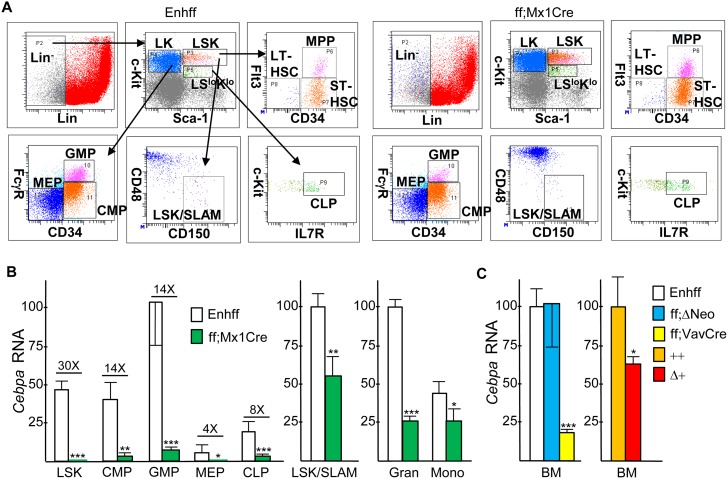
Effect of in vivo Enhancer Deletion on Cebpa Hematopoietic Expression.A) Representative FACS analyses of marrow stem/progenitor subsets. GMP, CMP, and MEP were analyzed within the Lin-Sca-1-c-kit+ (LK) subset, CLP were analyzed within the Lin-Sca-1loc-kitlo (LSloKlo) subset, and MPP, ST-HSC, LT-HSC, or LSK/SLAM cells were enumerated within the Lin-Sca-1+c-kit+ (LSK) subset. B) Total cellular RNAs from the LSK, CMP, GMP, MEP, CLP, LSK/SLAM, granulocyte, or monocyte marrow subsets isolated from Enh(f/f) or Enh(f/f);Mx1-Cre mice that had been subjected to pIpC injections and allowed to recover for 4 wks were analyzed for relative Cebpa mRNA expression, normalized to mS16 mRNA expression (mean and SD from three determinations). C) Relative Cebpa mRNA expression was analyzed similarly from marrow mononuclear cells isolated from Enh(f/f) mice versus mice lacking both PGK-Neo cassettes (ff;ΔNeo) or Enh(f/f);Vav-Cre mice and from wild-type (++) versus Enh(f+);CMV-Cre (Δ+) mice (n = 3).